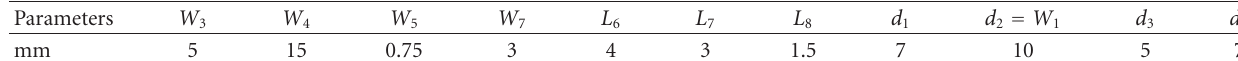
Table 2: Geometrical parameters of Figure 3.